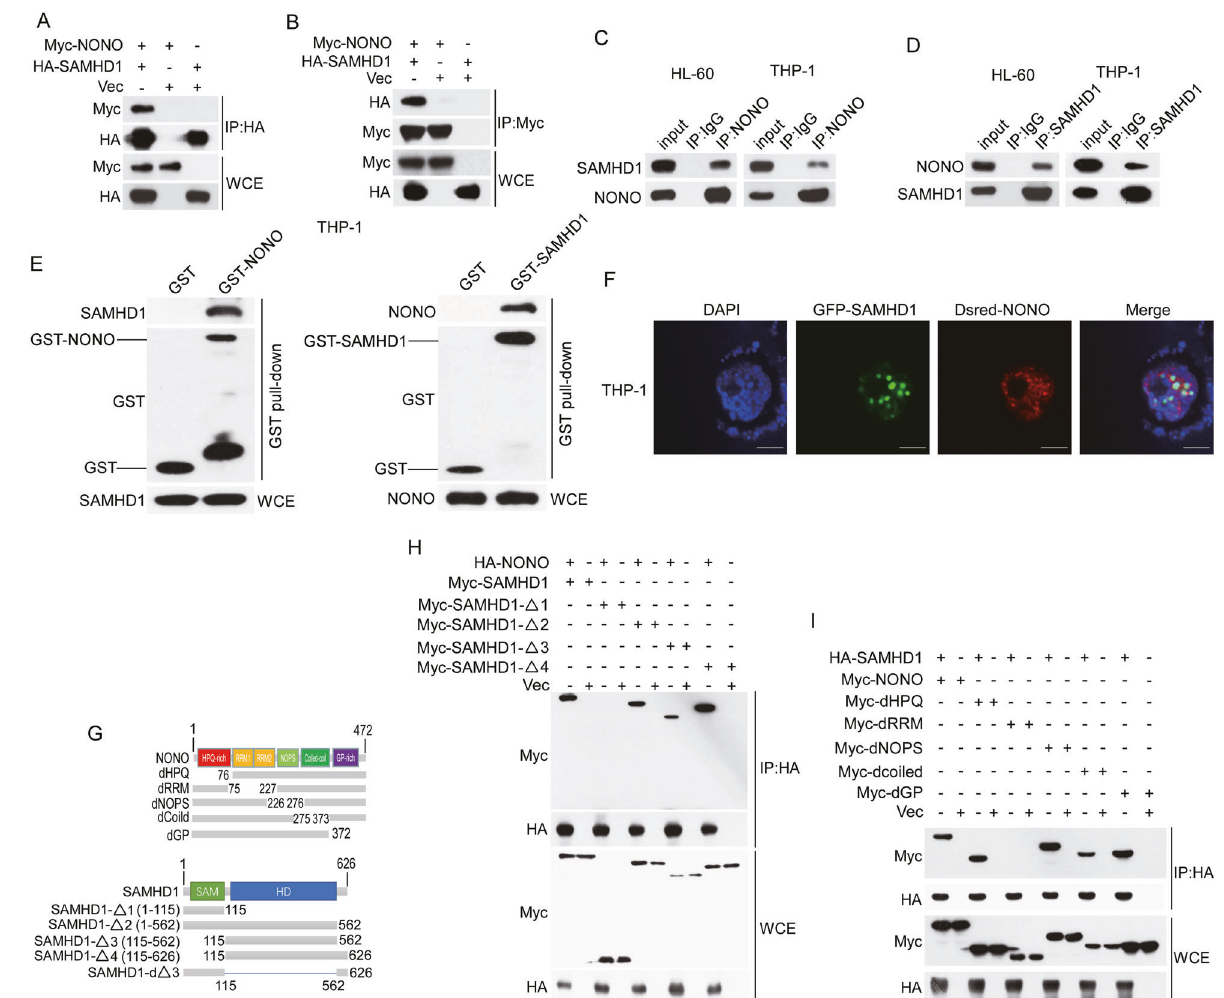
Fig. 1 SAMHD1 interacts with NONO. A , B Validation of the exogenous interaction between NONO and SAMHD1 by co-IP. HA-tagged SAMHD1 was cotransfected with Myc-tagged NONO into 293 T cells. Co-IP was performed with anti-HA or anti-Myc agarose, and the interactions were examined by western blotting. C , D Identi fi cation of the endogenous interaction between NONO and SAMHD1 in HL60 and THP-1 cells. Cell lysates were immunoprecipitated with an anti-NONO antibody, and the indicated proteins were examined by western blotting. IgG was used as the negative control. E NONO interacts with SAMHD1 detected by GST pulldown assay. E. coli-expressed GST-NONO, GST-SAMHD1, or GST (as a negative control) proteins were immobilized by Glutathione-Sepharose and then incubated with THP-1cell lysate. GST or GST-NONO, GST-SAMHD1 and pull downed proteins were examined by western blotting with indicated antibodies. F Identi fi cation of the co-location of NONO and SAMHD1 in THP-1 cells by immuno fl uorescence. GFP-SAMHD1 was cotransfected with Dsred-NONO into THP-1 cells for 24 h. Scale bar, 5 μ M. G Schematic diagram of NONO and SAMHD1 truncation mutants. H The domain of SAMHD1 containing amino acids 115-562 interacts with NONO. HA-tagged NONO was cotransfected into 293 T cells with wild-type or mutant Myc-SAMHD1, and the interactions were veri fi ed by co-IP and western blotting. I The RRM domain of NONO interacts with SAMHD1. HA-tagged SAMHD1 was cotransfected into 293 T cells with wild-type or mutant Myc-NONO, and the interactions were veri fi ed by co-IP and western